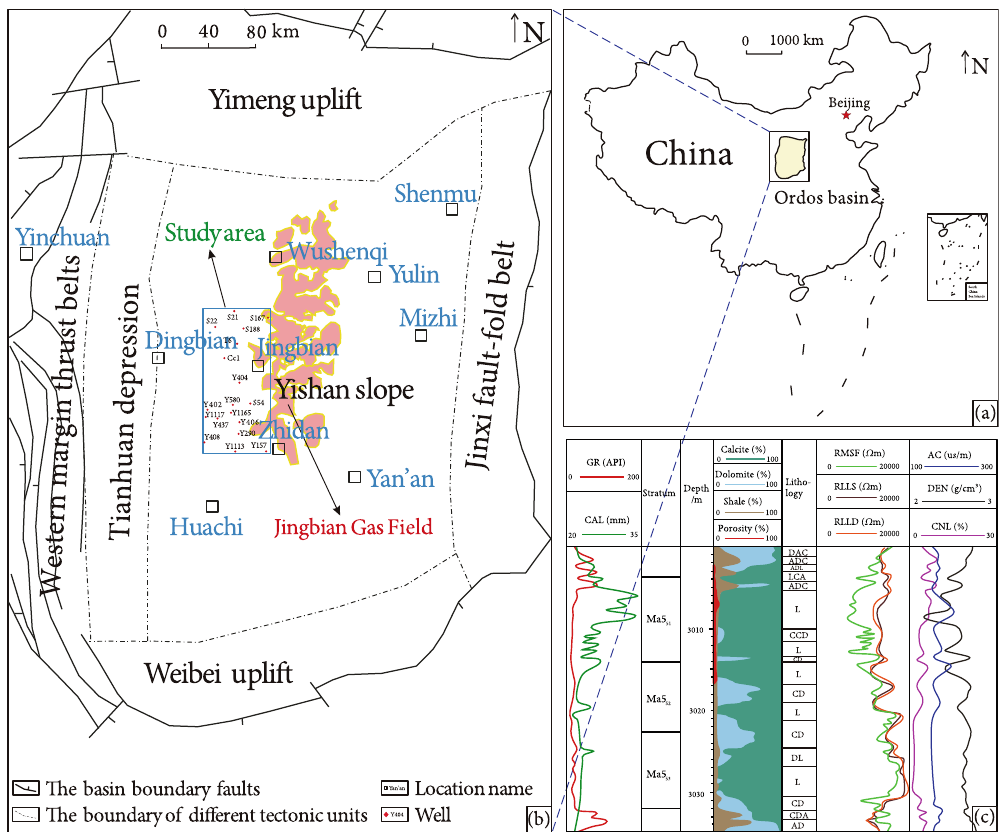
Figure 1: Geological settings of the western Ordos Basin. ((a) Location of the Ordos Basin. (b) Structural units, location of the study area, and sampling wells. (c). The comprehensive stratigraphic column of submember Ma5